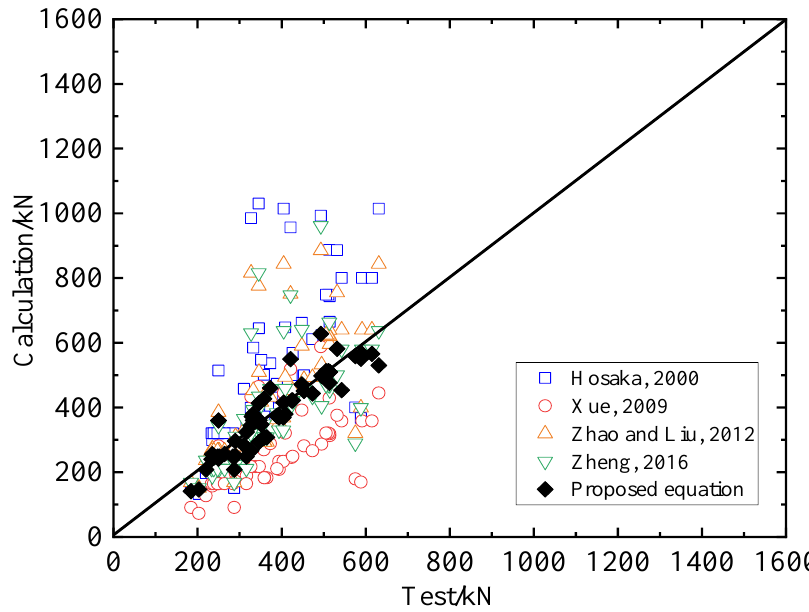
Figure 19. Evaluation of the proposed capacity equation.